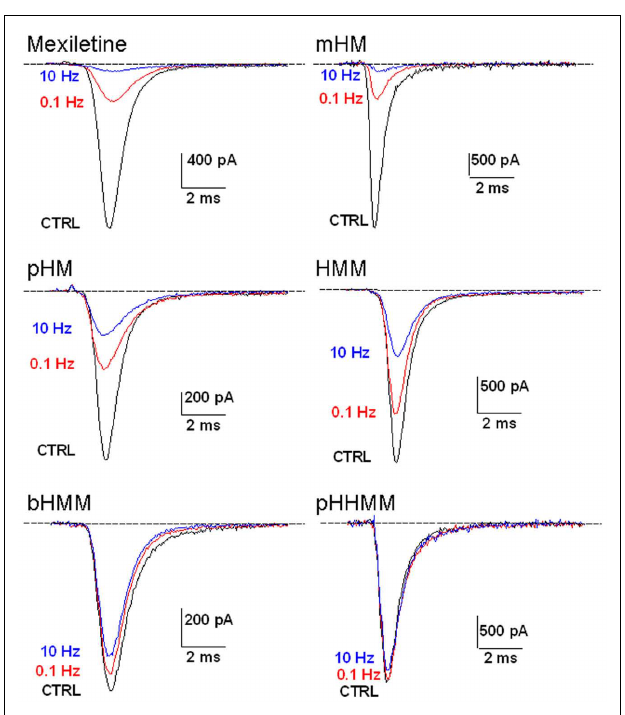
FIGURE 2 | Effects of 1mM mexiletine or hydroxylated analogs on hNav1.4 currents. Sodium currents were recorded as described in Figure 1